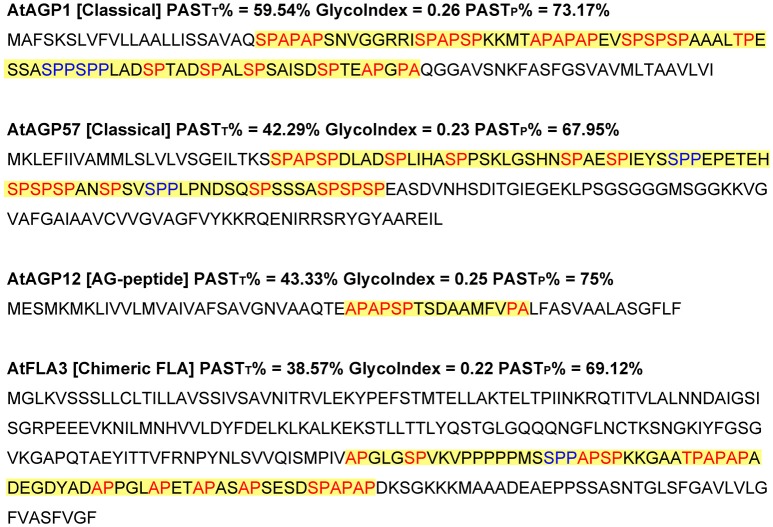
Illustration of the variables glycomodule index and partial PAST percentage of representative Arabidopsis AGPs. Red colored sequences indicate putative AG glycomodules (Ala-Pro, Pro-Ala, Ser-Pro, Pro-Ser, Thr-Pro, and Pro-Thr) and blue colored sequences indicate putative EXT glycomodules (Ser-Pro2−4). Total PAST percentage (PASTT%) and partial PAST percentage (PASTP%) represent the PAST percentage in whole protein sequences and AGP-like sequences, respectively. GlycoIndex, glycomodule index.